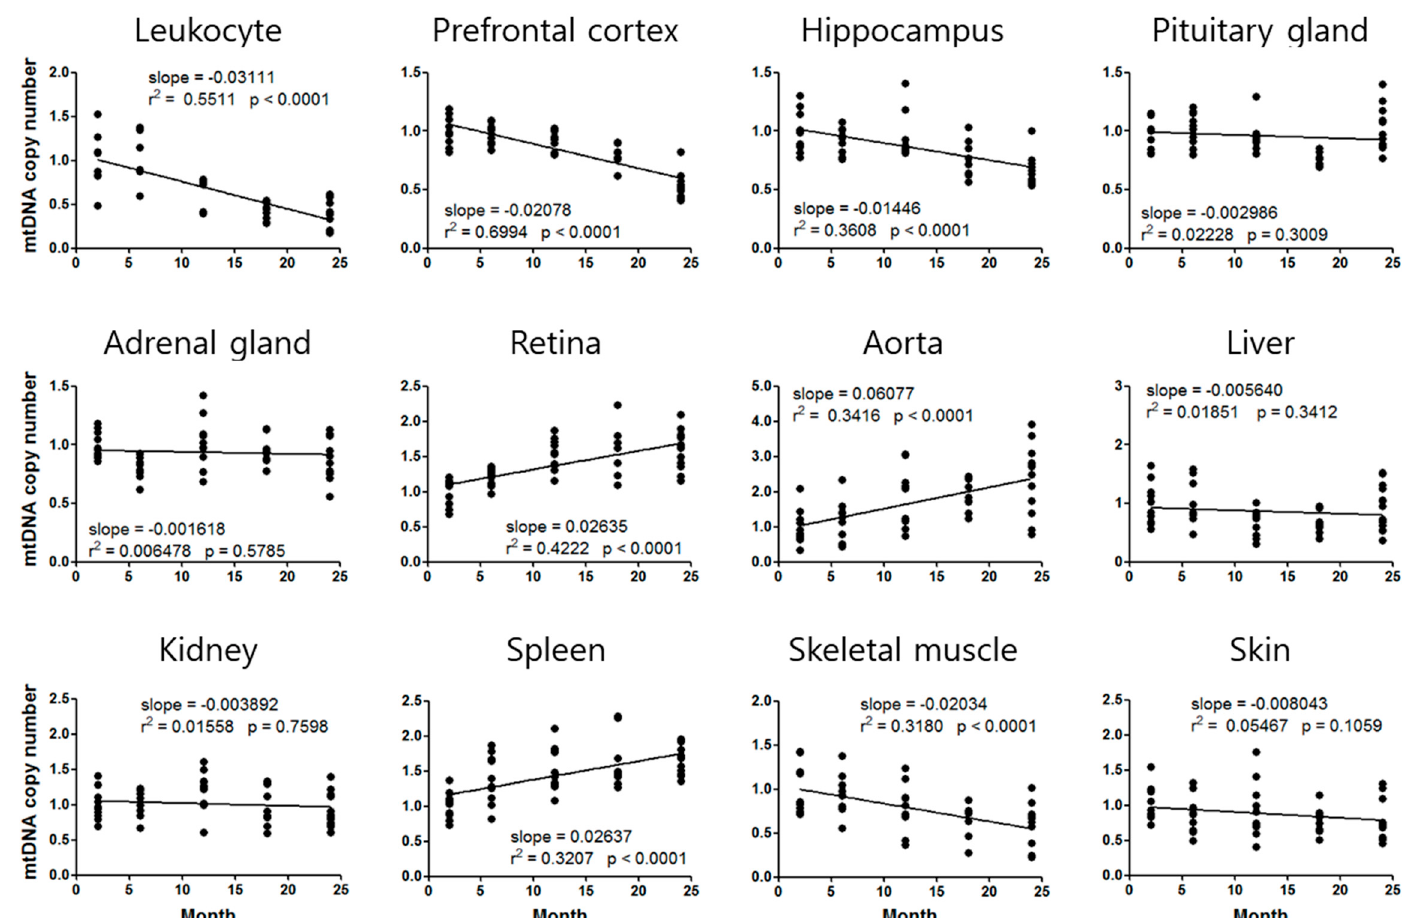
Figure 2. Aging standard curves for mitochondrial DNA copy number of C57BL/6 male mice. The relative mtDNAcn (analyzed by Cox2 ) at 2 months is normalized to 1. The slope of the linear regression line, goodness of fit ( r 2 ), and p -value (whether a slope is significantly non-zero) are provided for each curve.